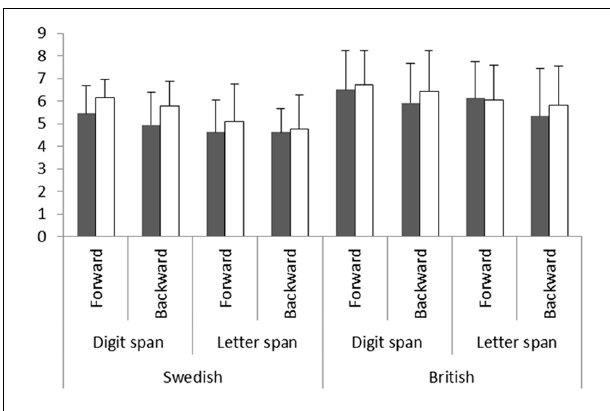
FIGURE 2 | Mean forward and backward digit and letter spans (and standard deviation) in Swedish and British deaf signers (grey bars) and hearing non-signers (white